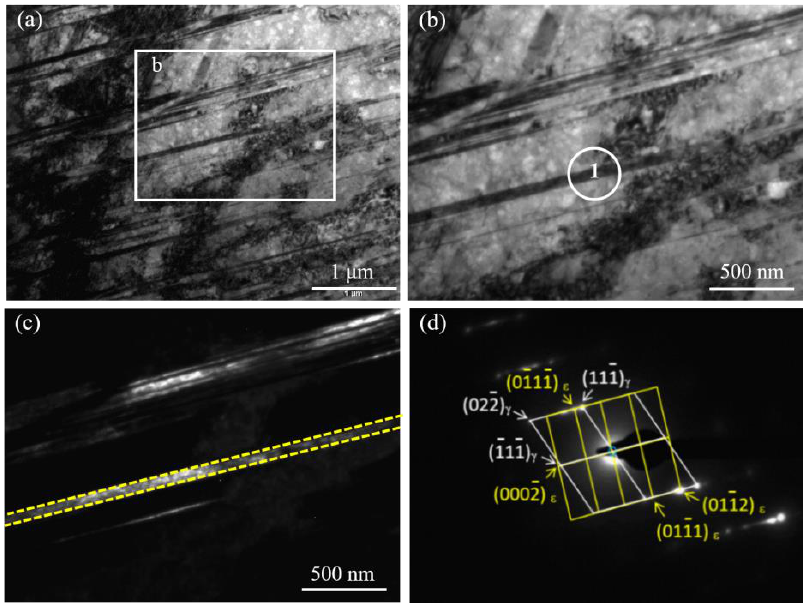
Figure 7. TEM microstructures of the specimen subjected to two thermomechanical cycles after 2.5% strain at 77 K: ( a ) bright-field image; ( b ) enlarged image of area b in ( a ); ( c ) dark-field image using (0 1̅ 1 1̅ )ε reflection; ( d ) selected-area diffraction pattern corresponding to area 1 shown in ( a ), zone axis = [2 1̅1̅ 0]ε, zone axis = [01 1̅ ]γ.